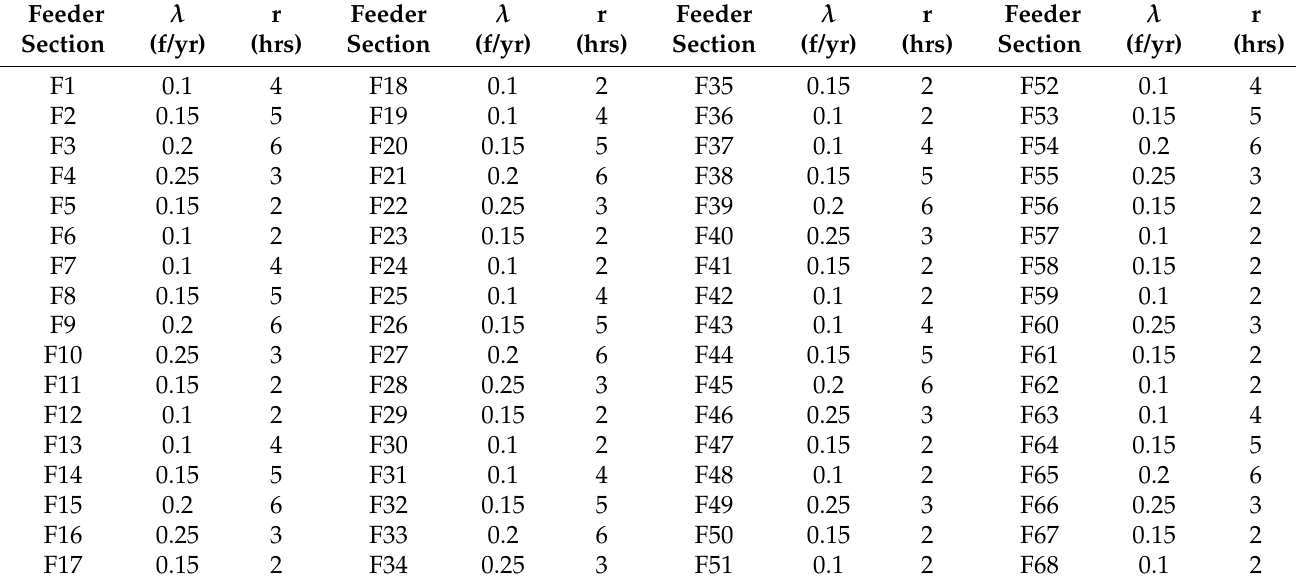
Table 5. Data for system failure of the 69-bus test system.